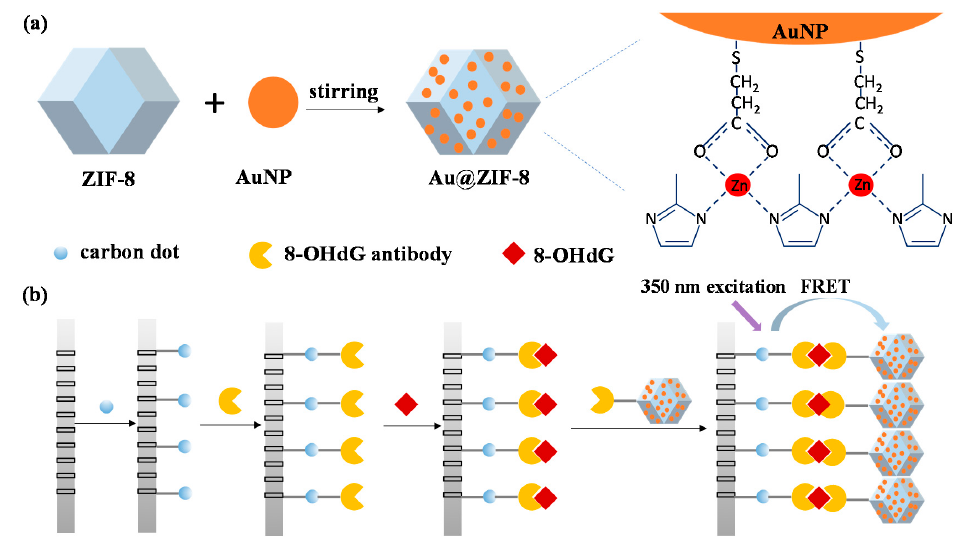
Figure 1. Schematic representation of the synthesis process of Au@ZIF-8 nanoparticles ( a ) and 8-hydroxy-2 ′ -deoxyguanosine (8-OHdG) detection by nanoporous alumina membranes-based fluorescence resonance energy transfer (FRET) biosensor with carbon dots (CDs) and Au@ZIF-8, respectively, as fluorescence donors and acceptors ( b ).